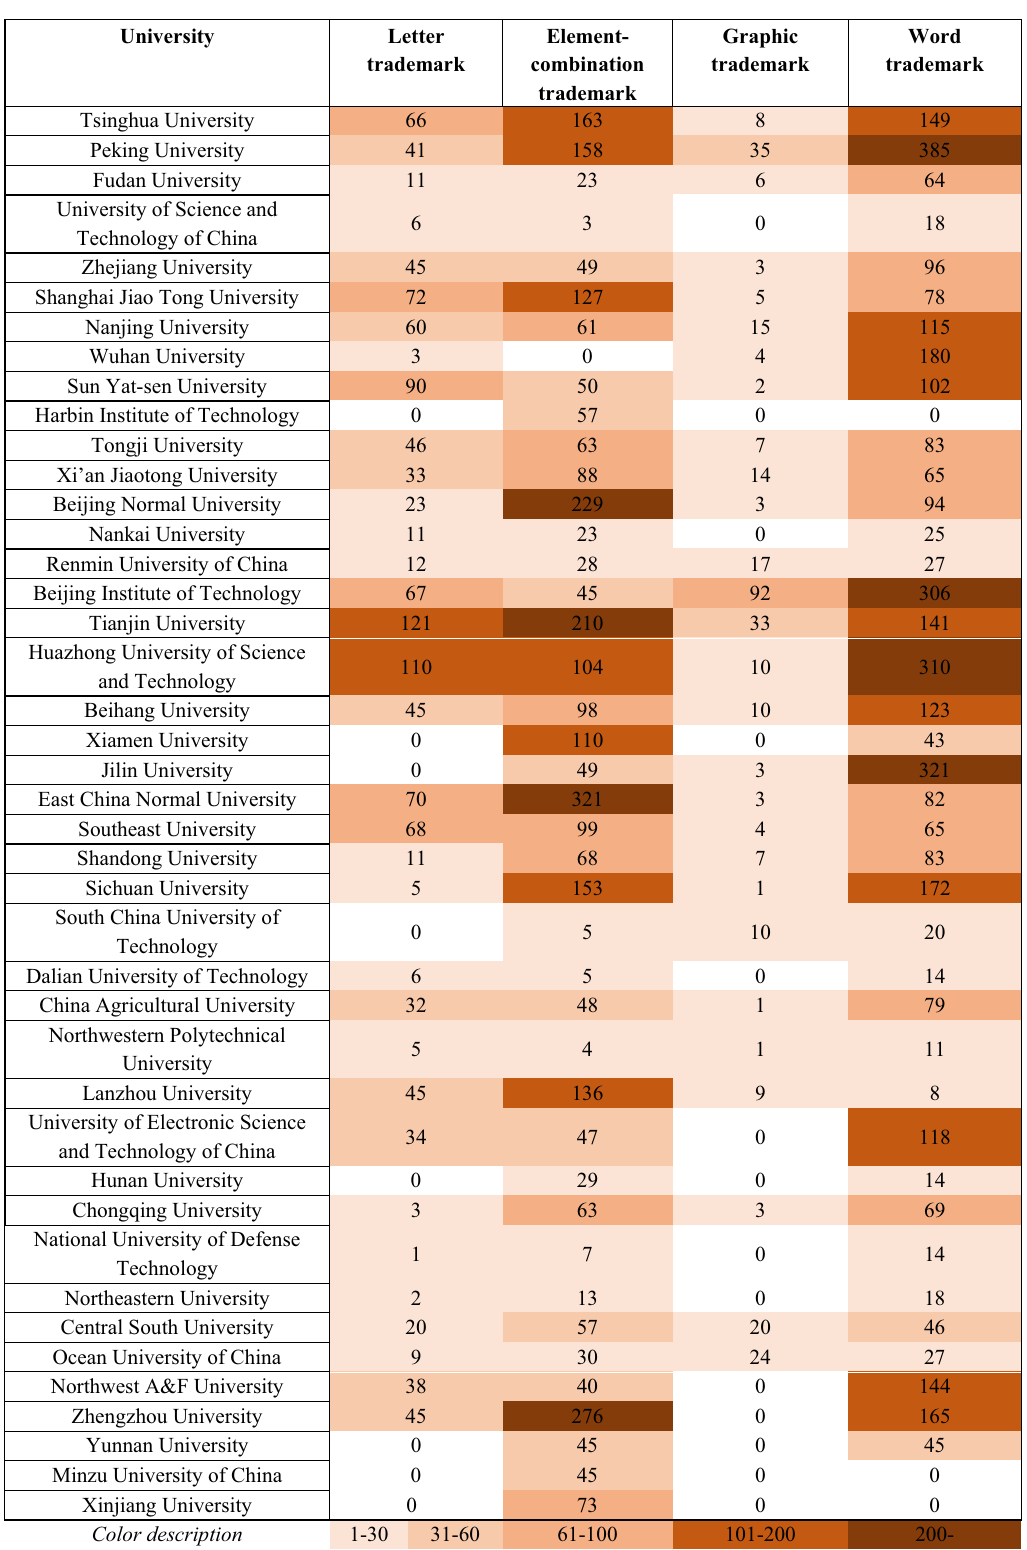
Table 3 Distribution of trademark elements of the 42 fi rst-class